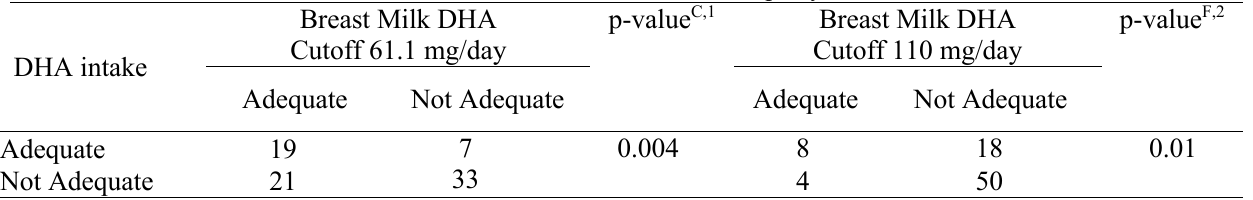
Table 5. Association between DHA intake and Breast Milk DHA adequacy of different cutoff. DHA intake Adequate Not Adequate Adequate